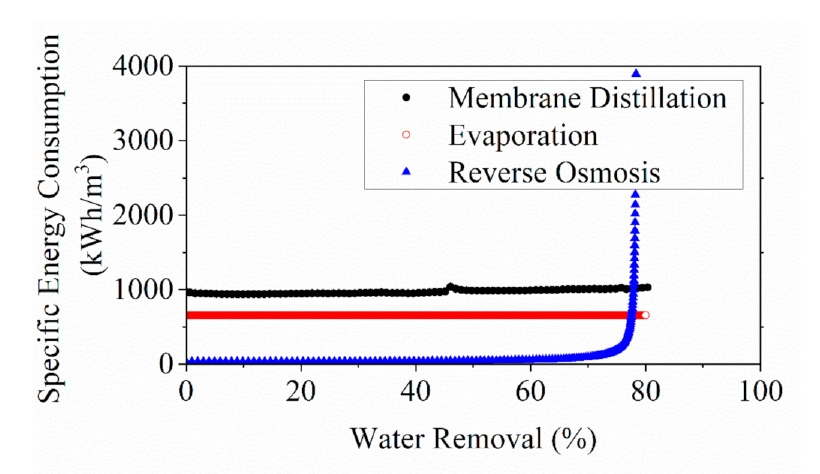
Figure 12. Comparison of energy consumption for herbal extract (Yu-Ping-Feng-San) concentration processes via different technologies, namely thermal evaporation, MD and RO using simulated